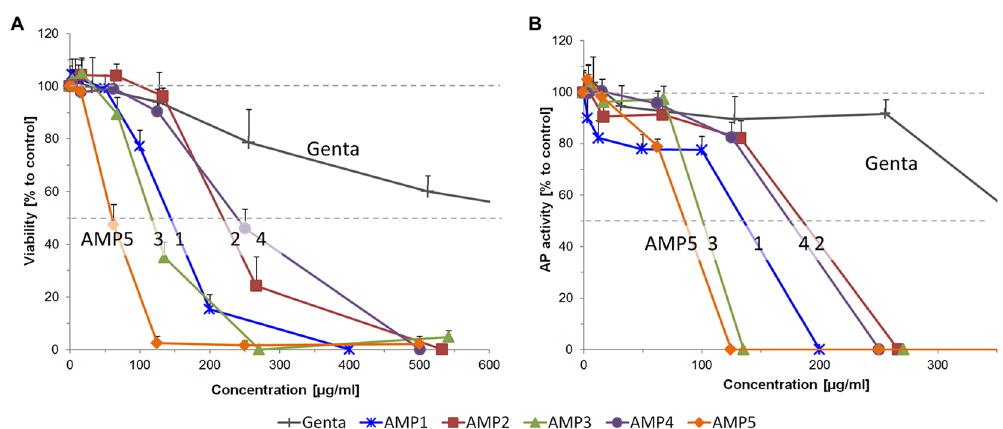
Figure 2. Human primary osteoblast-like cells were cultured with different concentrations of AMP and gentamicin for three days. Viability (A) and alkaline phosphatase (AP) activity (B) were determined. Values for AP were normalized to 10 4 cells and compared to control (untreated cells, 100%). Results are means of n = 6, cells from two donors, triplicates.). Data are shown as means with standard deviation. Kruskal-Wallis, Mann-Whitney, Bonferroni-Holm post-hoc test. Significant inhibition compared to the control group, viability: AMP1 ≥ 100 µ g/ml, AMP2 ≥ 267 µ g/ml, AMP3 ≥ 68 µ g/ml, AMP4 ≥ 251 µ g/ml, AMP5 ≥ 63 µ g/ml;